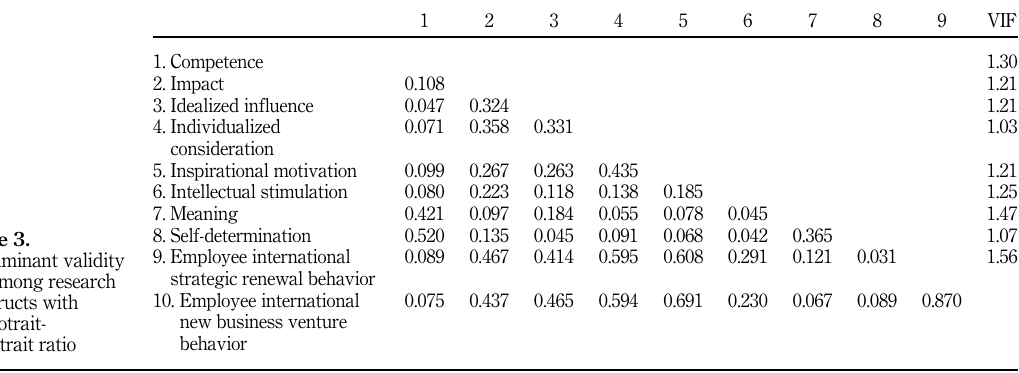
Table 3. Discriminant validity test among research constructs with Heterotrait- Monotrait